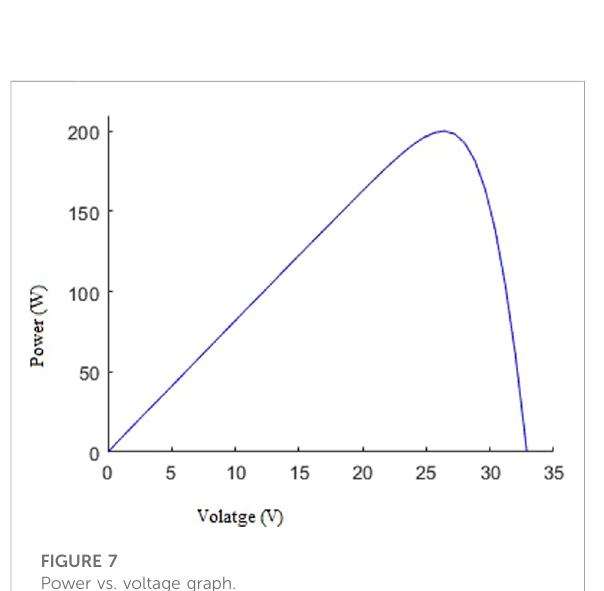
FIGURE 6 Current vs. voltage graph.